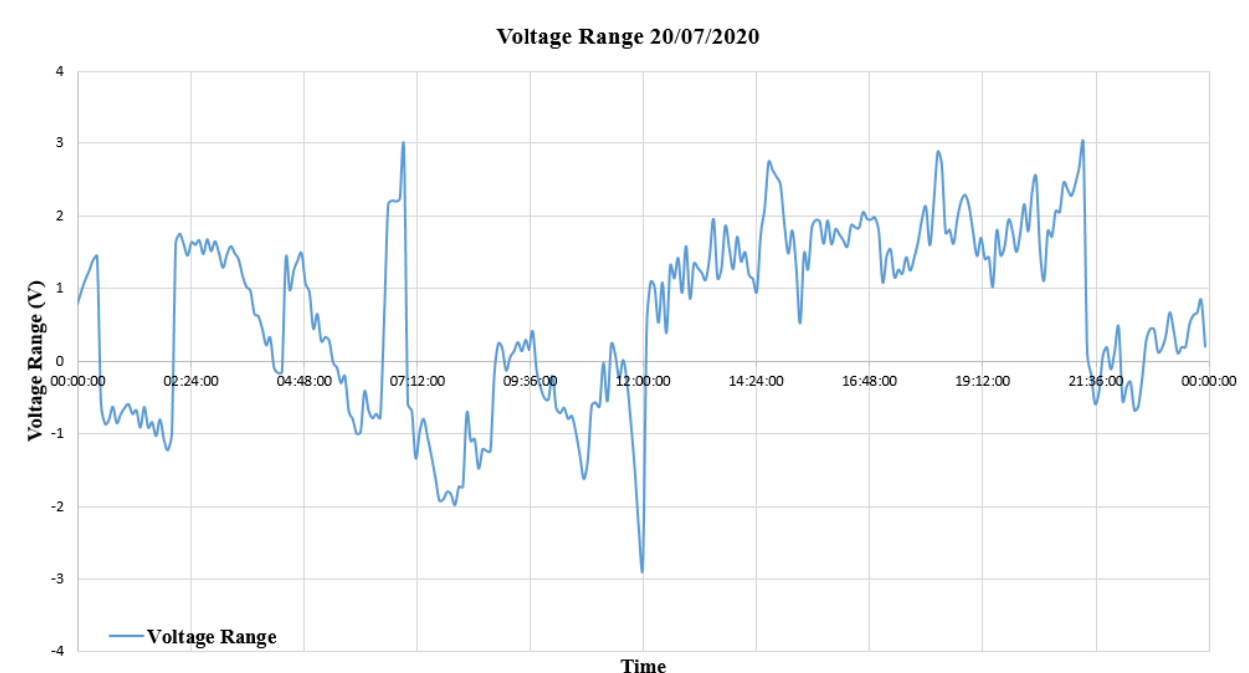
Figure 29. Voltage deviation observed within the MCAST micro-grid during a typical weekday.